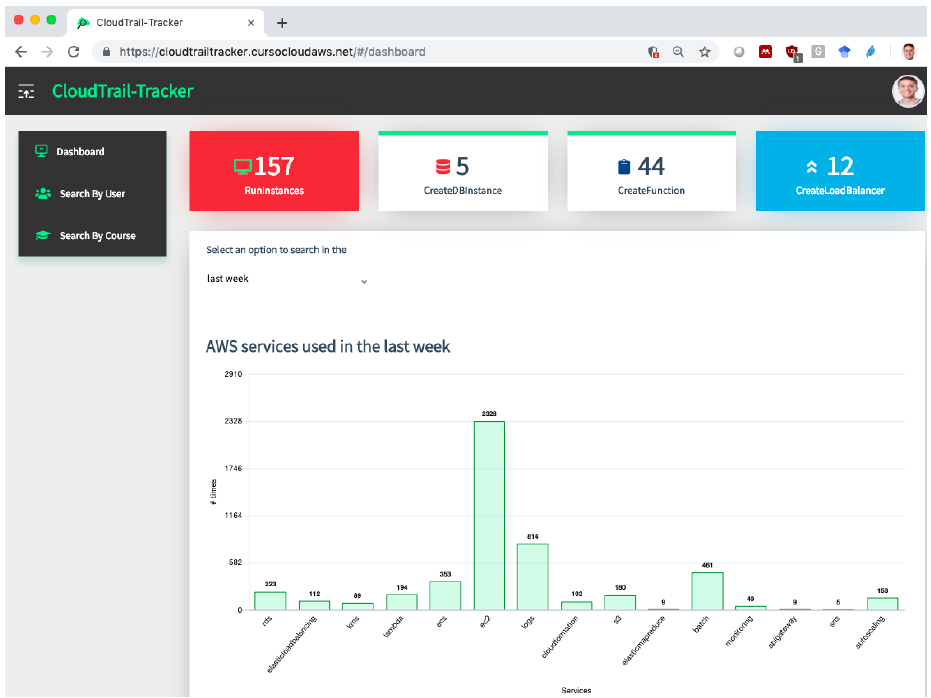
Figure 2. Initial dashboard provided by CloudTrail-Tracker showing aggregated usage statistics of the AWS account.